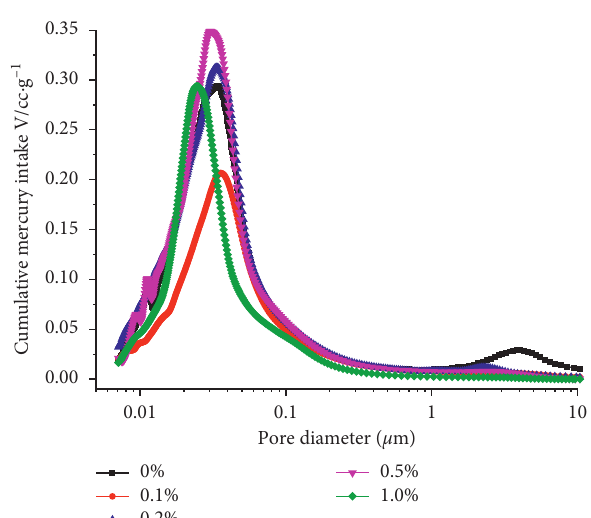
Figure 10: Relationship between aperture and cumulative mercury intrusion.